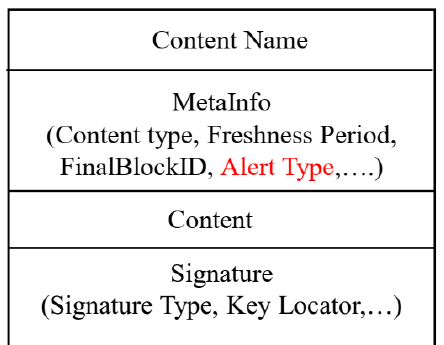
Figure 3. Enhanced Data Packet